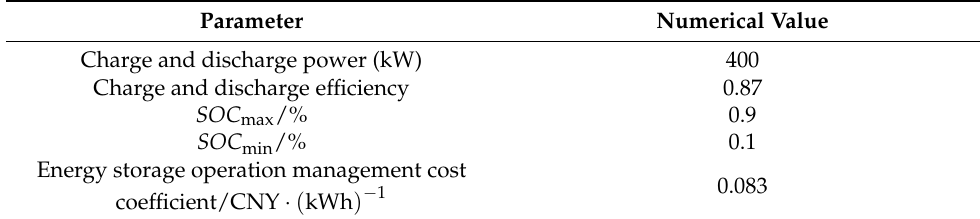
Table 4. The partial parameters of energy storage system.